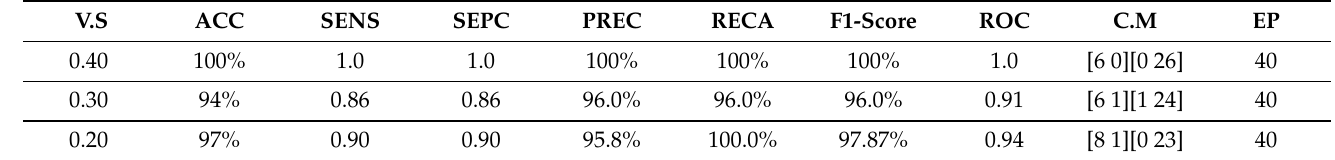
Table 2. SGD (rate of learning 0.001; momentum = 0.9). The loss function is cross-categorical entropy